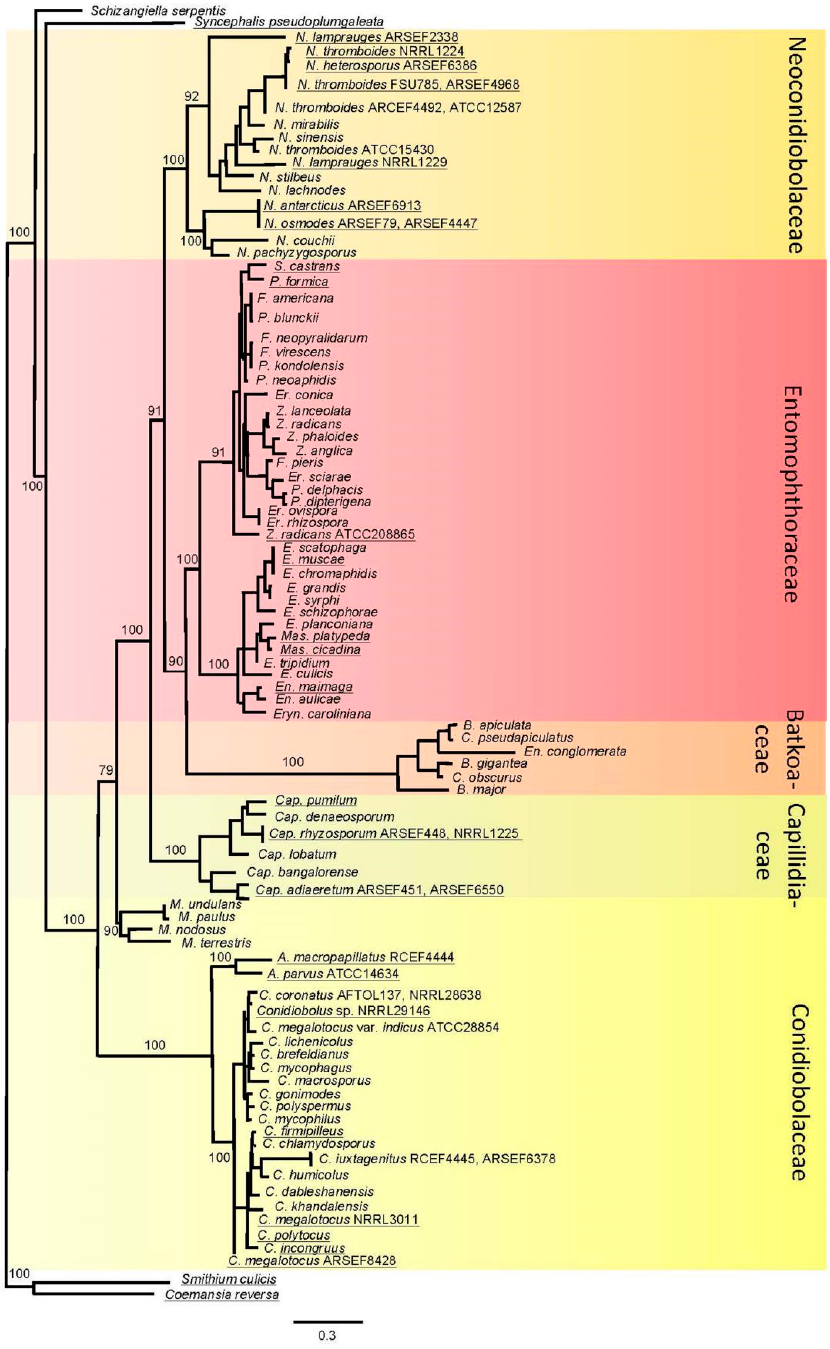
Figure 2. Maximum likelihood phylogenetic tree of conidiobolus-like fungi and related groups. Bootstrap values shown only at the basal nodes. In the genus Batkoa, the old taxonomic names of B. apiculata ( Conidiobolus pseudapiculatus and Entomophaga conglomerata ) and B. gigantea ( C. obscurus ) are shown to demonstrate the difficulties of species identification using only morphological features.